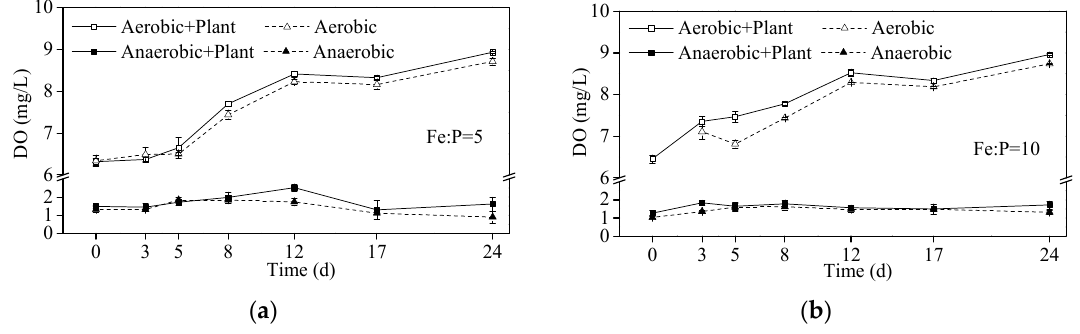
Figure 1. Variation of dissolved oxygen (DO) in the overlying water. ( a ) Iron: phosphorus ratio (Fe:P) = 5; ( b ) Fe:P = 10. Error bars represent the standard errors.